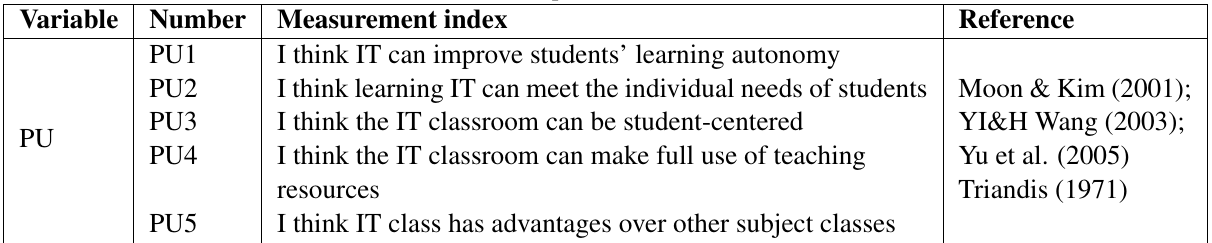
Table 1 Perceptual usefulness measures